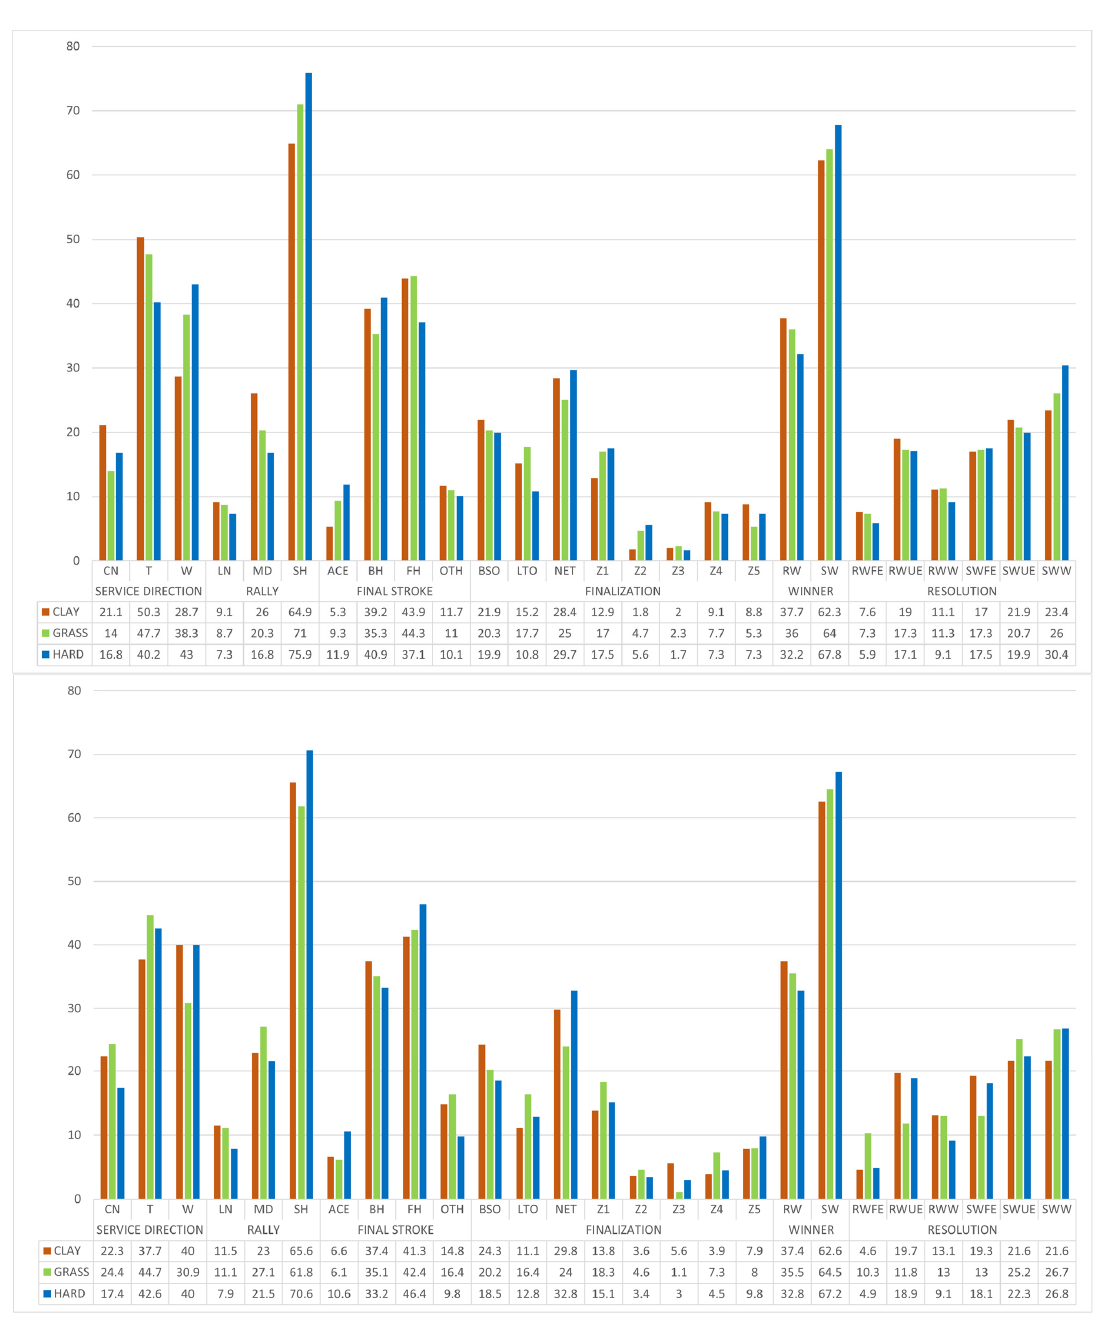
Figure 3. Distribution of the points played with first service to the deuce and the advantage side.